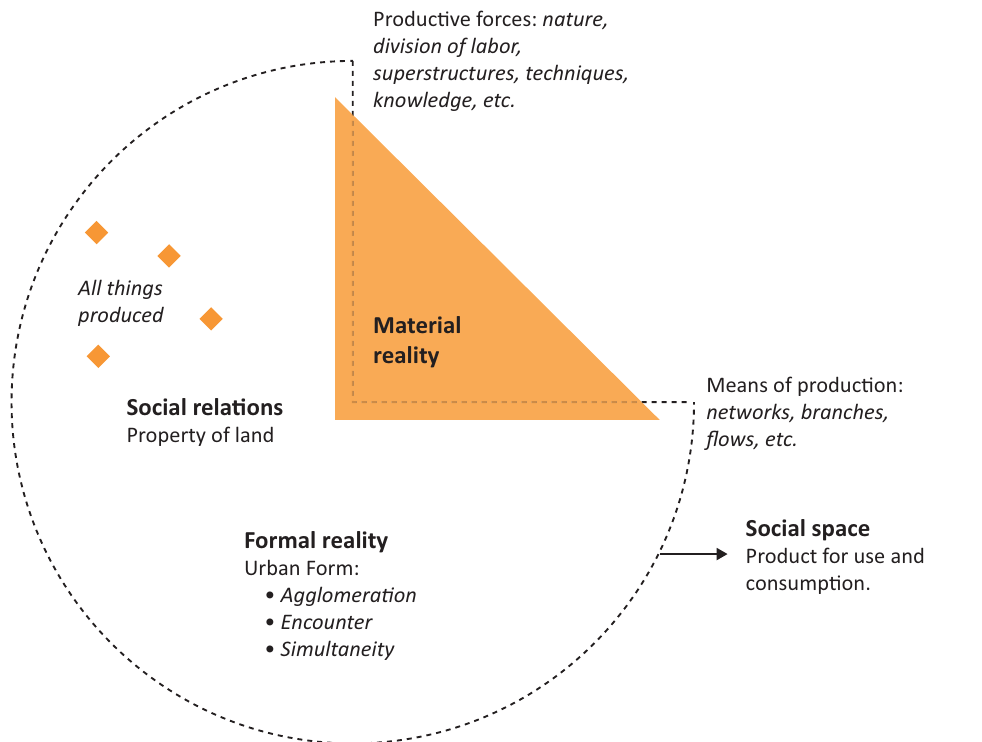
Figure 1. Diagram of the complex reality of social space. Source: Jiménez Pacheco